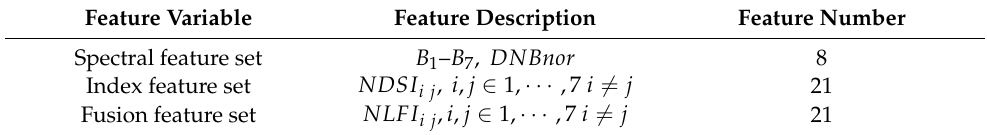
Table 2. Description of constructed feature